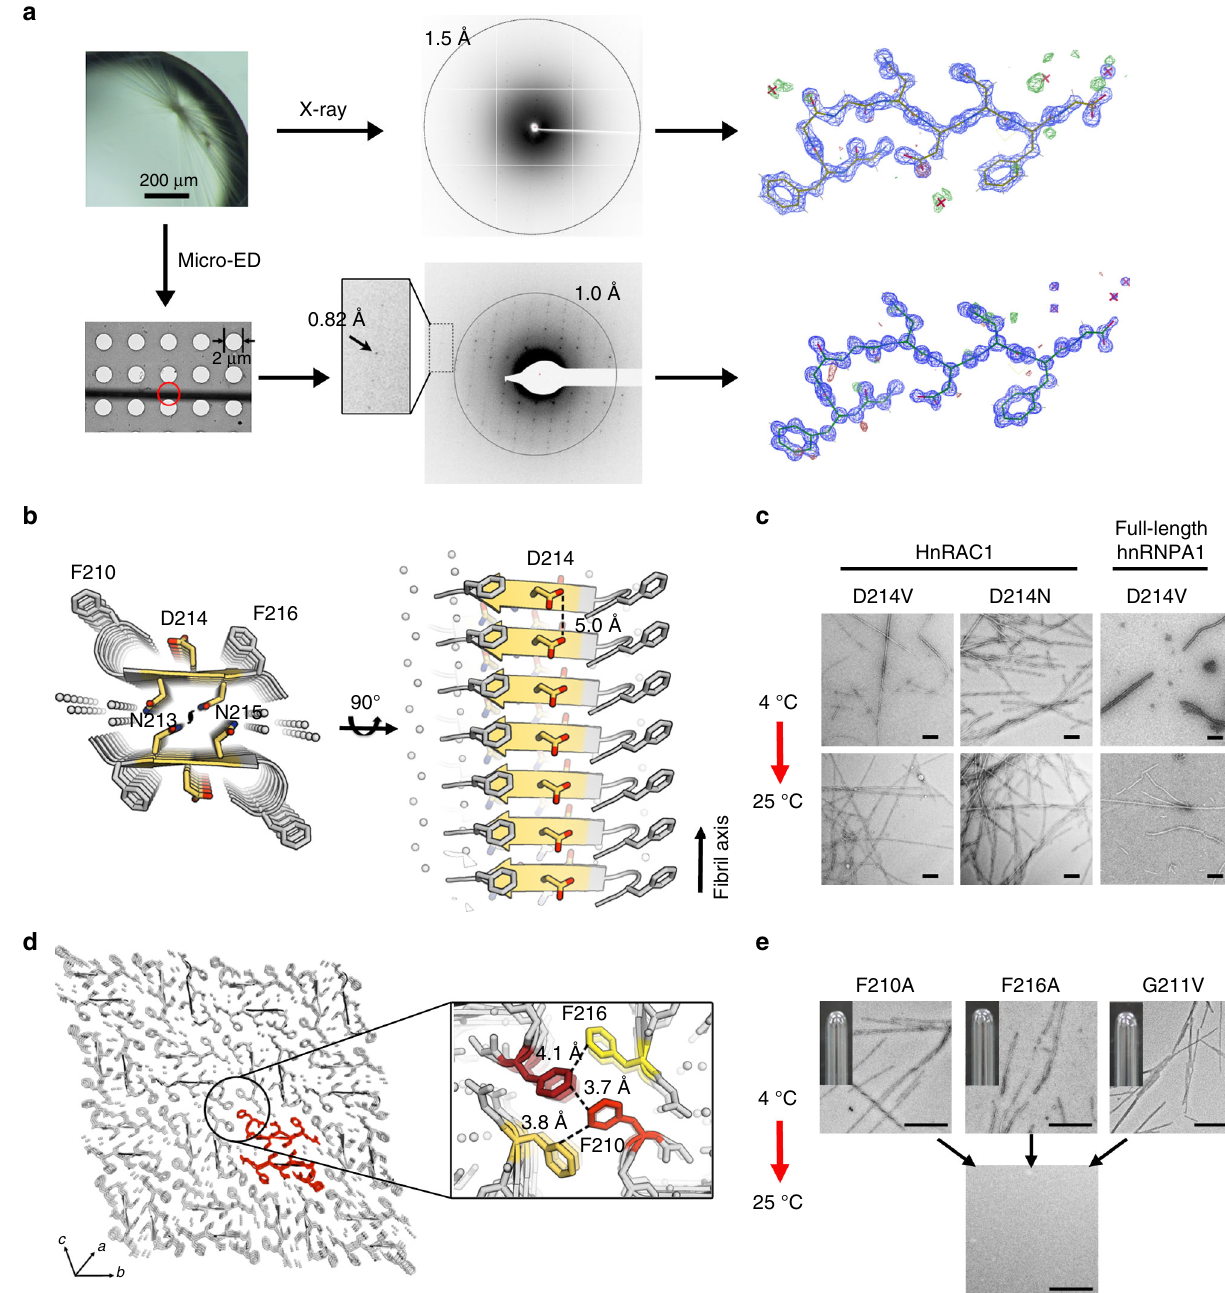
Fig. 3 Structure determination and mutagenesis of hnRAC1. a Atomic structures of hnRAC1 determined by micro-ED and X-ray diffraction. The red circle on EM grid indicates the shooting spot of electron beam. HnRAC1 crystals diffracted electron beam to the highest resolution of 0.82 Å. The structure of hnRAC1 was solved at the resolution of 1.0 Å by micro-ED and 1.4 Å by X-ray diffraction. Structure models and density maps of hnRAC1 were shown. 2 Fo - Fc maps are contoured at 2.0 rmsd (blue). Fo - Fc maps are contoured at 3.0 rmsd (green and red). Red crosses represent water. b The atomic structure of hnRAC1 in the fi brillar form. The structure features a cross- β architecture with a hydrophilic interface composed of N213 and N215, that together with D214, form the fi bril core (colored in yellow). Residue side chains are shown as sticks. Nitrogen atoms are in blue. Oxygen atoms are in red. Water molecules are shown as spheres. The two-fold screw axis is indicated. The distance between Asp residues from neighboring β -strands in the same sheet is indicated. c Effects of D214 mutations on hnRAC1 and full-length hnRNPA1 fi bril reversibility. The mutations resulted in fi brils that unlike the reversible wild-type fi brils remained stable as warmed up to 25 °C. Scale bars are 200 nm. d The crystal lattice of hnRAC1 viewed down the fi bril sheets. The unit of fi bril spine is colored in red. Inter- fi brillar π – π interactions are shown in the zoom-in view. Phe residues involved in π – π interactions are from four neighboring hnRAC1 molecules. Distances between Phe residues are indicated. F210 residues are colored in red. F216 residues are in yellow. e Effects of inter- fi brillar interactions on hydrogel formation. Mutations of F210A, F216A, and G211V all disrupted the formation of hydrogels, whereas the mutants can still form reversible fi brils. Scale bars are 200